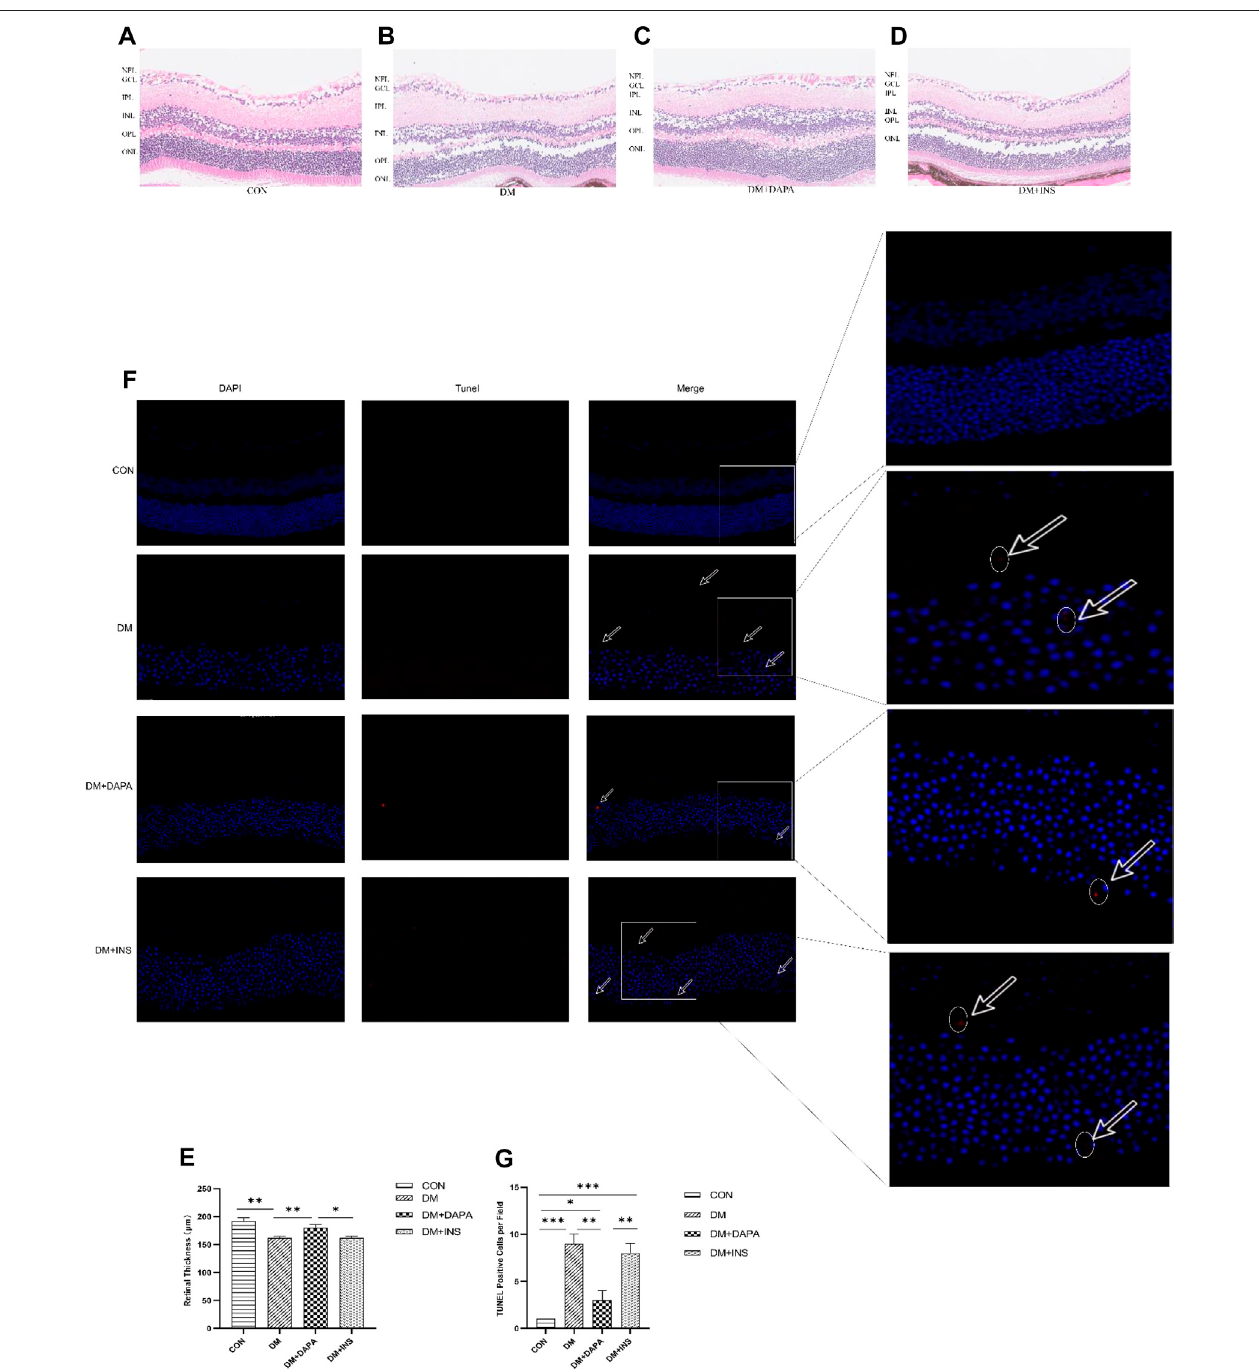
FIGURE 2 | Effect of DAPA on diabetic mice retinal apoptosis. (A – E) H&E staining and retinal thickness analysis of mice retinal tissue. Scale bar: 250 μ m. NFL: nerve fi ber layer. GCL: ganglion cell layer. IPL: inner plexiform layer. INL: inner nuclear layer. OPL: outer plexiform layer. ONL: outer nuclear layer. (F,G) TUNEL staining image of mice retinal tissue and percentage of TUNEL positive cells. Scale bar: 50 μ m. Data are presented as means ± SD. * p < 0.05, ** p < 0.01, *** p < 0.001.